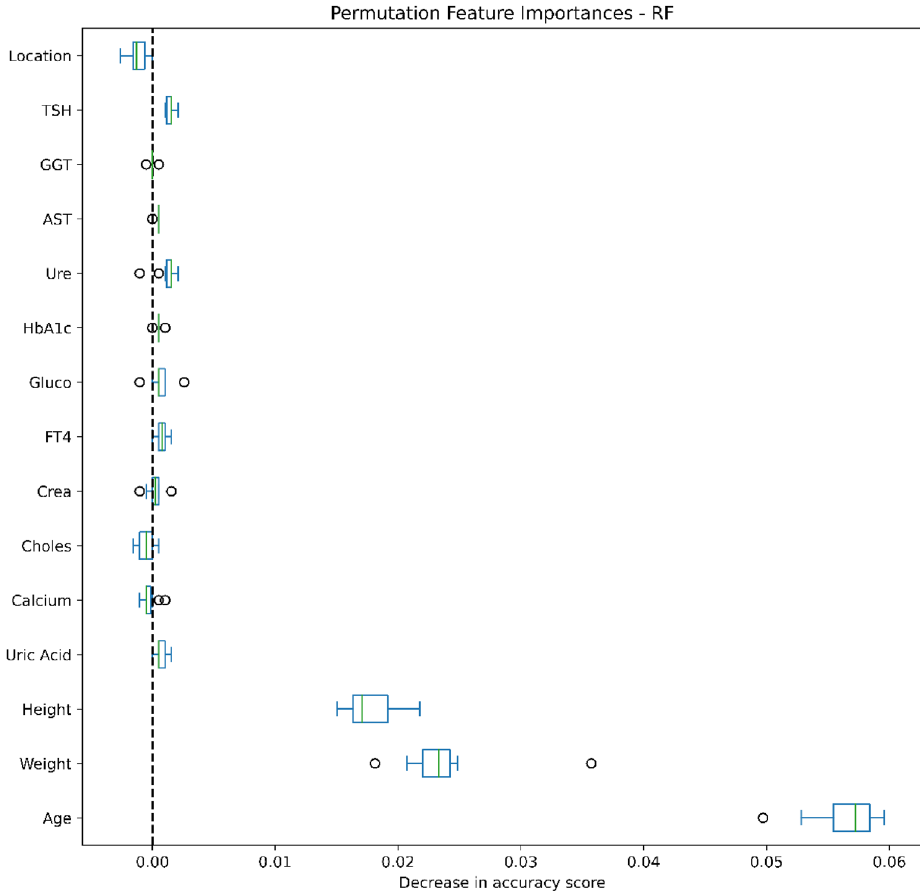
Figure 9. Feature importance for RF in the second